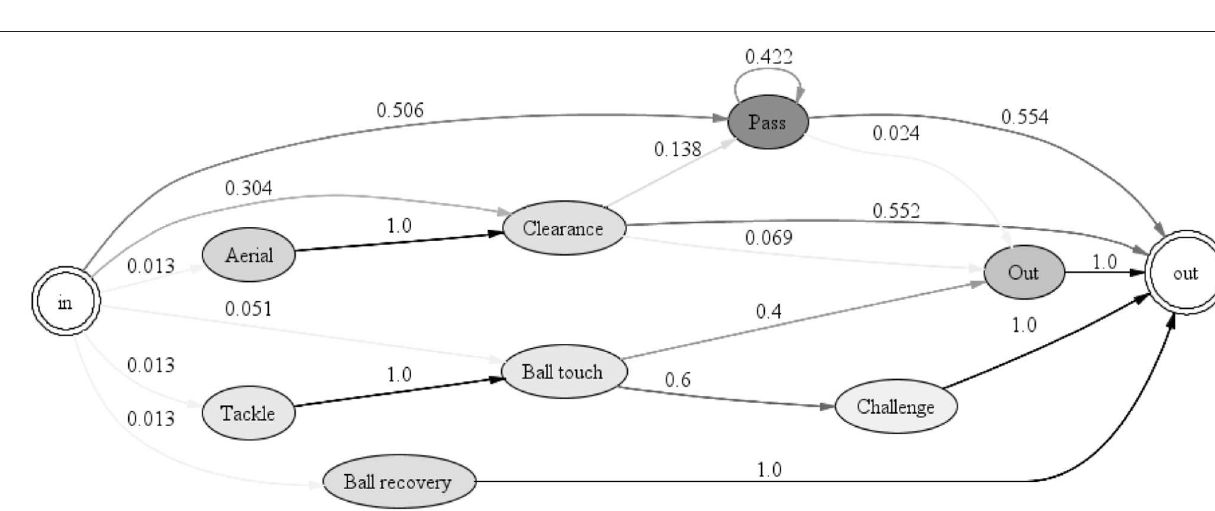
FIGURE 9 | Markov chain for Iceland’s team: cluster 1 with 79